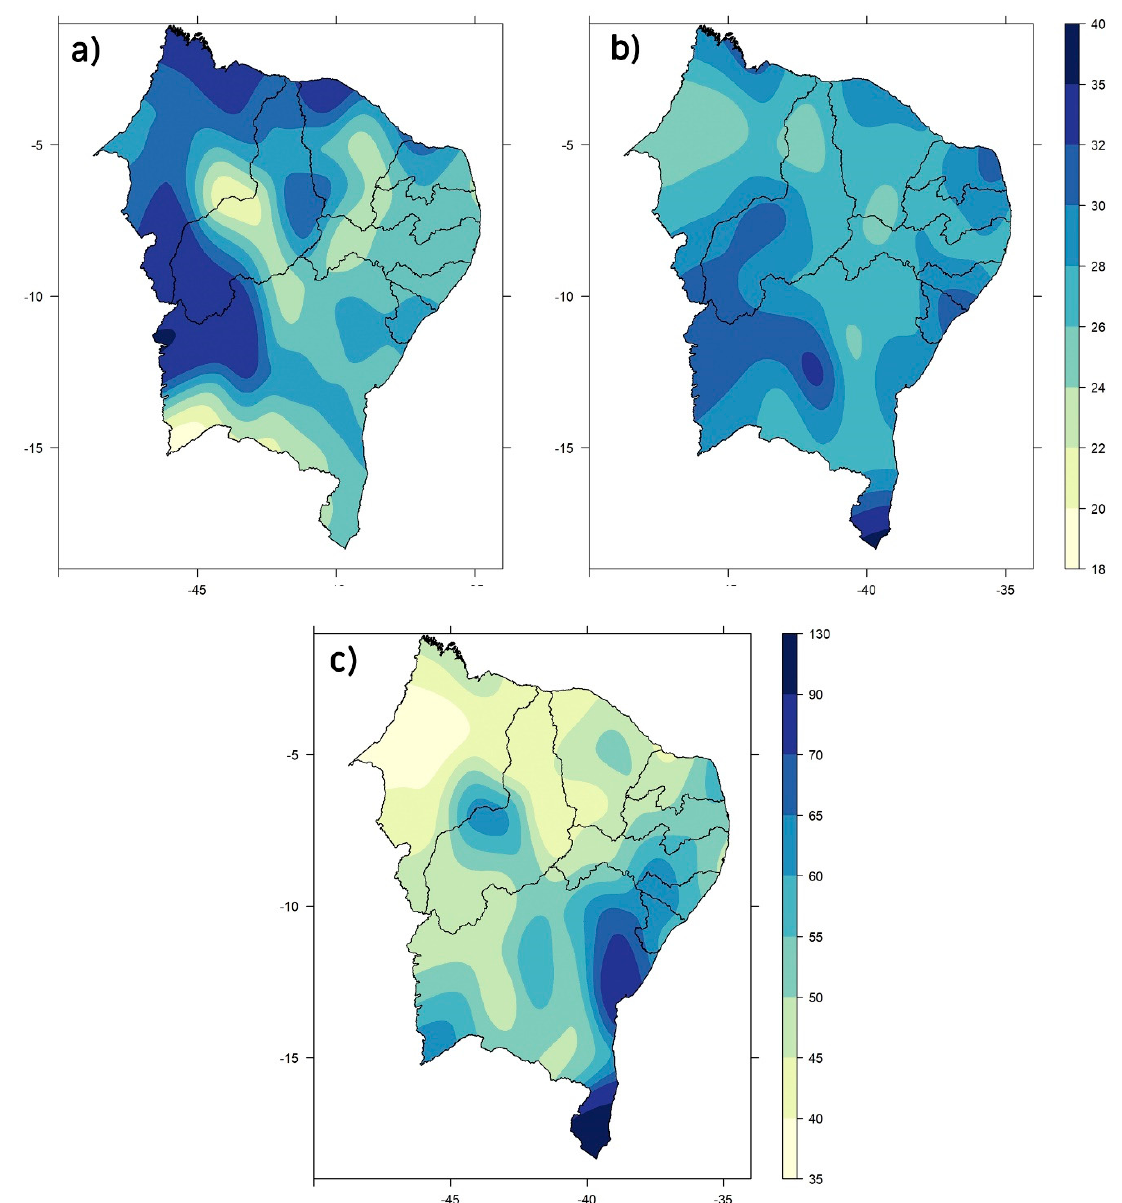
Figure 7. Return period (months) for a) weak drought, b) moderate drought and c) strong drought.